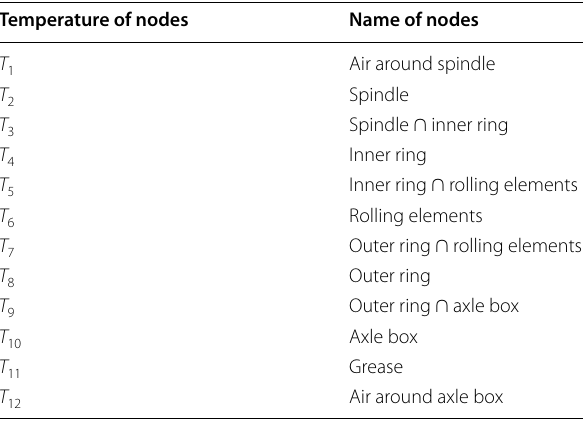
Table 1 Isothermal